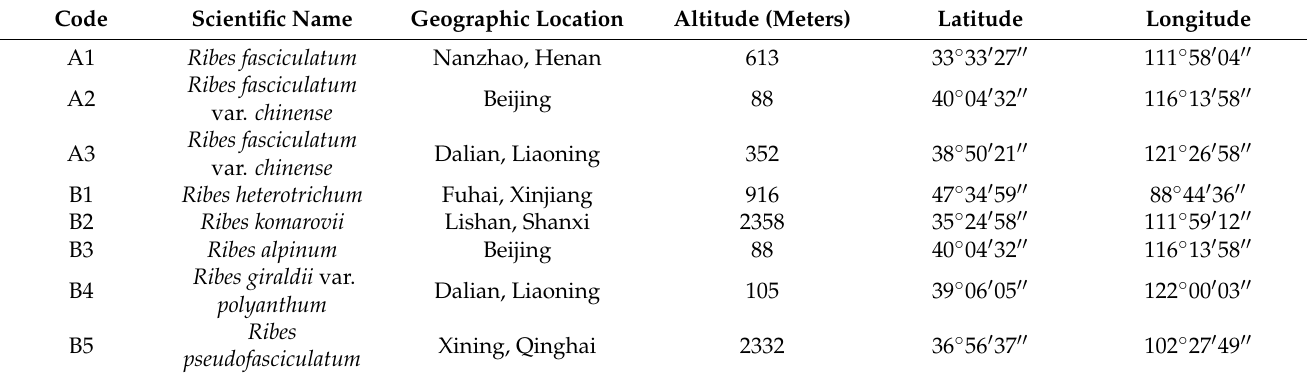
Table 2. Code, scientific name, geographic location, altitude, latitude, and longitude for Ribes L. samples collected in